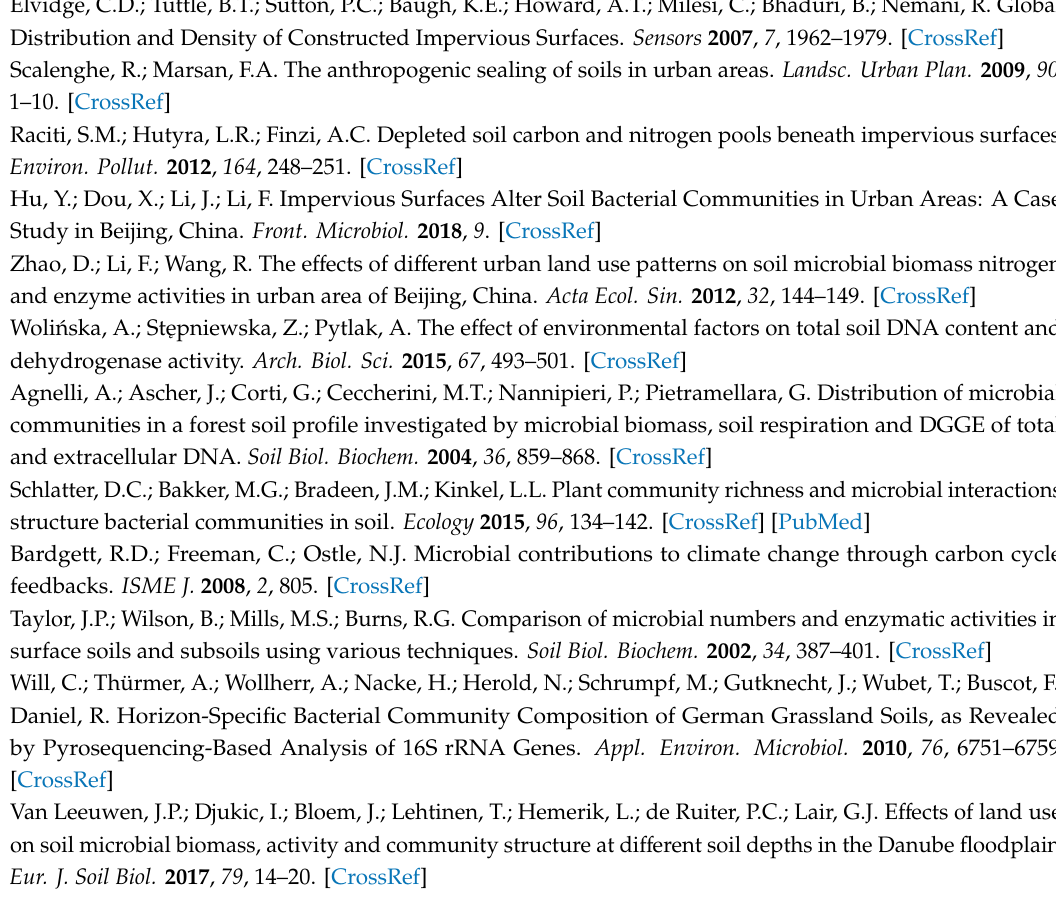
Table S1: The two-way analysis variance of soil physical and chemical properties across land pavement. Data are expressed as mean ± SE, n = 3. SMC: soil moisture content; TC: total carbon; SOC: soil organic carbon; TN: total nitrogen; DOC: dissolved organic carbon; AP: available phosphorus; AK: available potassium. PP: pervious pavement; IPP: impervious pavement; NP: non-pavement, Table S2: Pearson’s correlation between soil characteristics and the relative abundance of abundant